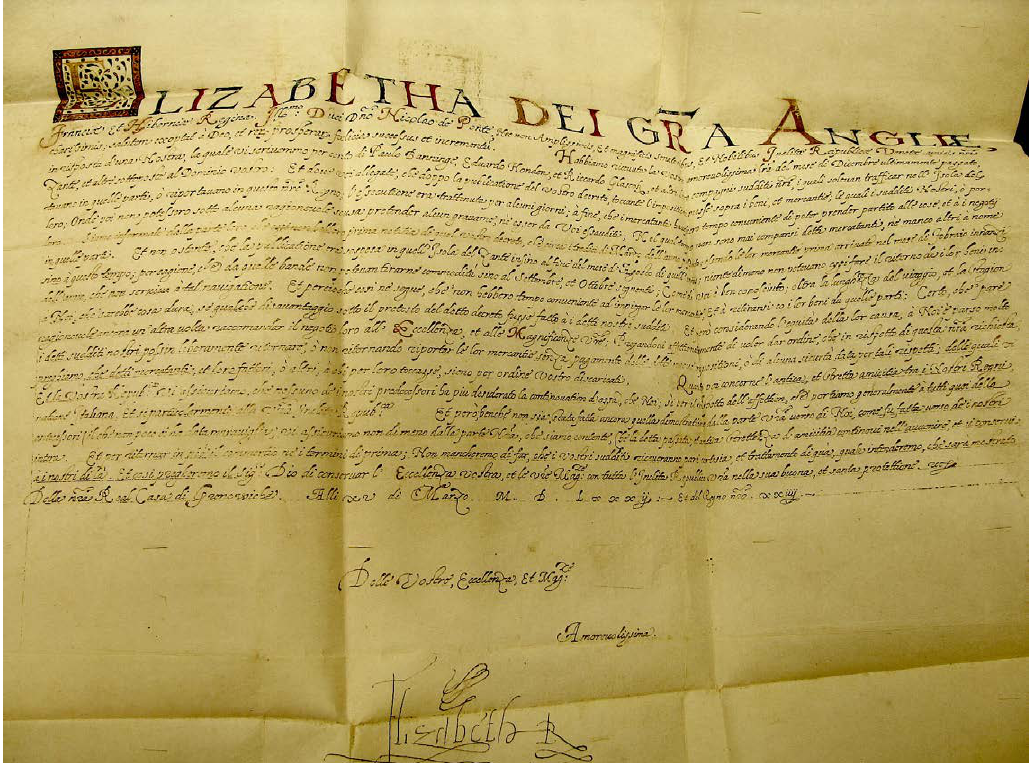
Fig. 6b – Letter to the Doge and Signory of Venice penned by scribe ‘C’ and signed by Elizabeth, 1582 (Collegio, Lettere Principi, filza 33, fol. 7; reproduced by permission of the Italian Ministero dei Beni Culturali; Archivio di Stato di Venezia, atto di concessione n.